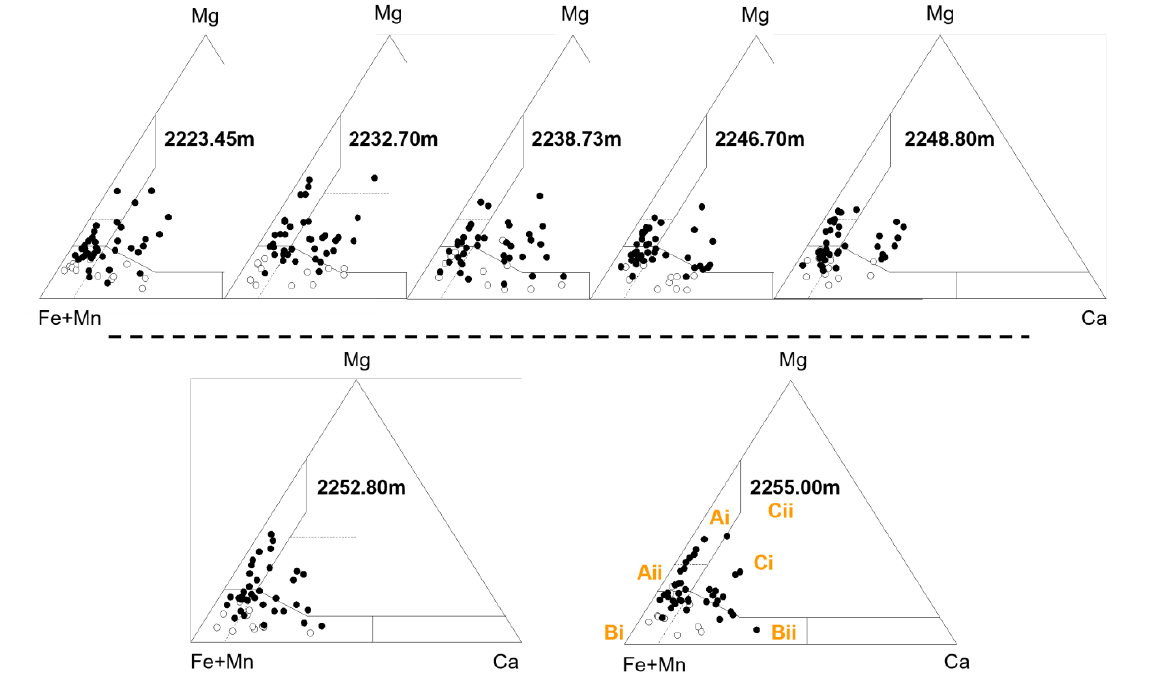
Figure 8. Ternary plots showing garnet assemblage compositions in the Hermod S2 Mbr of 24/9-10S, attributed to southern Hermod S2 Mbr. (Mg—Pyrope, Fe + Mn—Almandine + Spes- sartine, Ca—Grossular). Filled circles—garnets with < 5% Spessartine; open circles—garnets with >5% Spessartine. Dashed line separates garnet assemblages showing signatures similar to Foula Fm (2252.80 & 2255.00 m) from those similar to Otter Bank Fm (2223.45–2248.80 m).